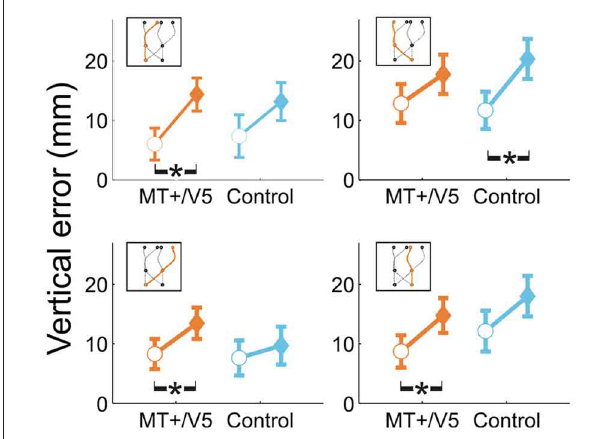
FIGURE 5 | The horizontal standard deviation of interception errors ) for MT + /V5 and its control site as a function of target position ( σ Error x at interception (A and B) and for SPOC and its control site Cz as a function of target position at movement initiation (C and D). Asterisks indicate significant differences; near-significant differences are also